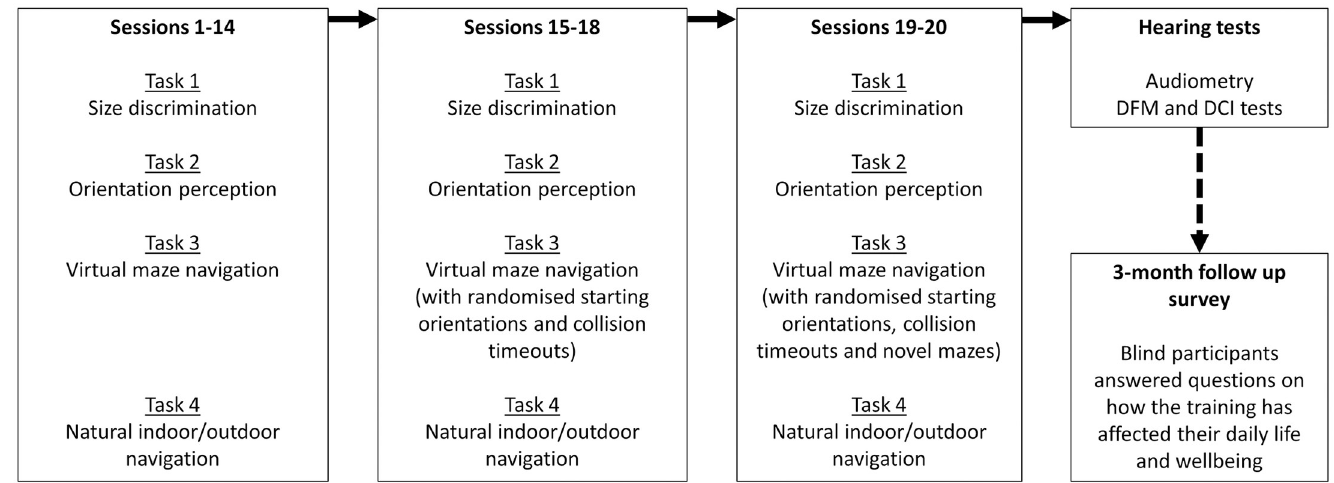
Fig 1. An illustration of the general procedure for data collection for a single participant. Note that tasks were done in different orders across participants and sessions, and this flowchart is just for illustration. In each of the 20 training sessions, each participant performed four separate tasks—size discrimination, orientation perception, virtual maze navigation, and real indoor/outdoor navigation. Please see the main text for descriptions of each of the tasks. For practical reasons, the natural navigation task was always done either in the beginning or the end of a session (in approximately equal parts). The other, lab-based, tasks were run in different orders across participants, with participants being able to choose the order if they wished. An additional session was used to acquire basic measurements of participants’ hearing (audiometry and DFM/DCI hearing tests)–please see the main text for details. Note that for some participants these were acquired before training began, rather than after (as indicated in the figure). For blind participants, they were contacted 3 months following training completion to complete a survey.